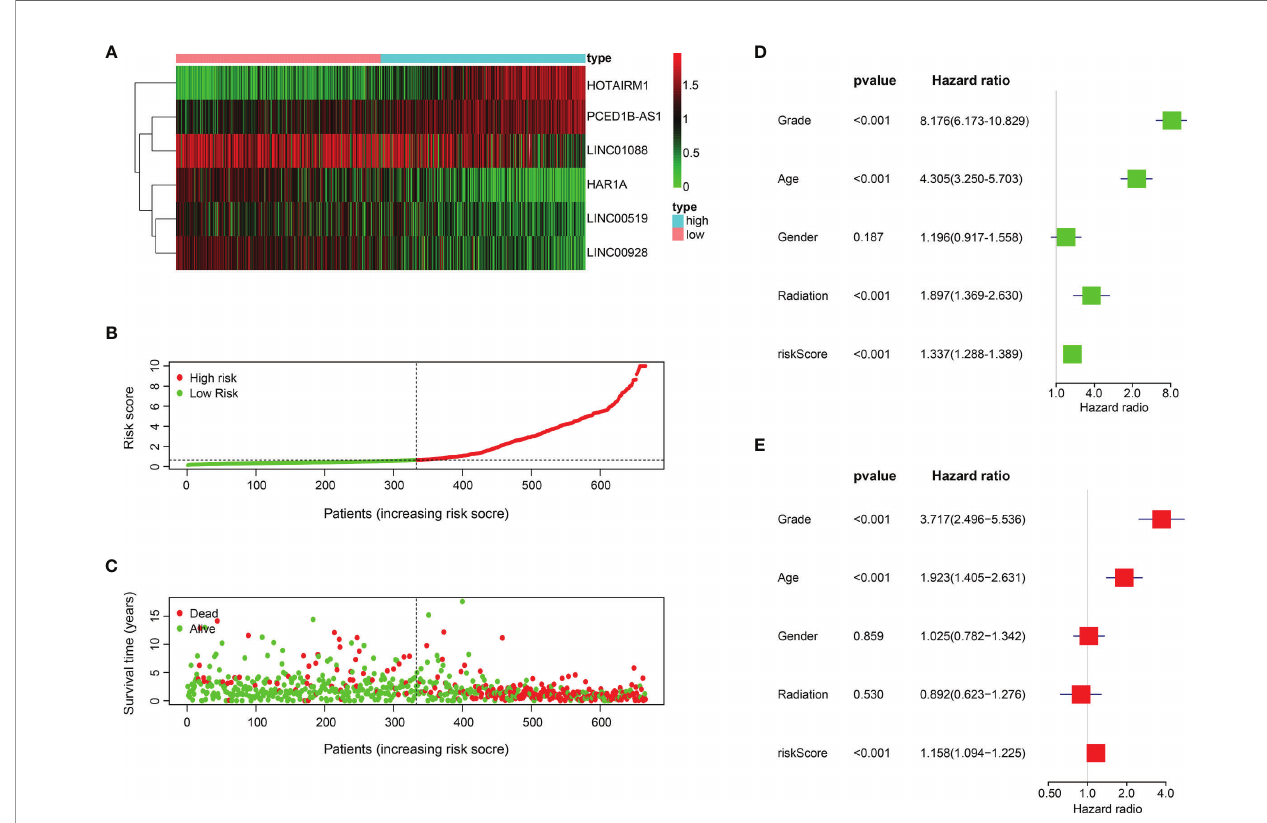
FIGURE 3 | The prognostic value of the 6 ER stress-related lncRNAs. (A) 6 ER stress-related lncRNA expression pro fi les. (B, C) Distribution of survival status, OS, and risk score in training set. (D, E) Univariate (D) and multivariate (E) Cox regression analyses in training